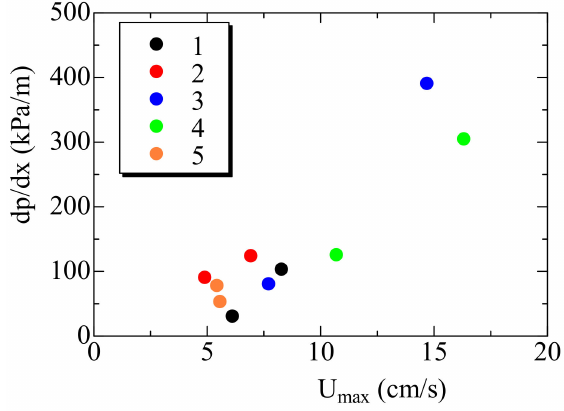
Figure 11. Relationship between the maximum filtration velocity and local pressure gradient.